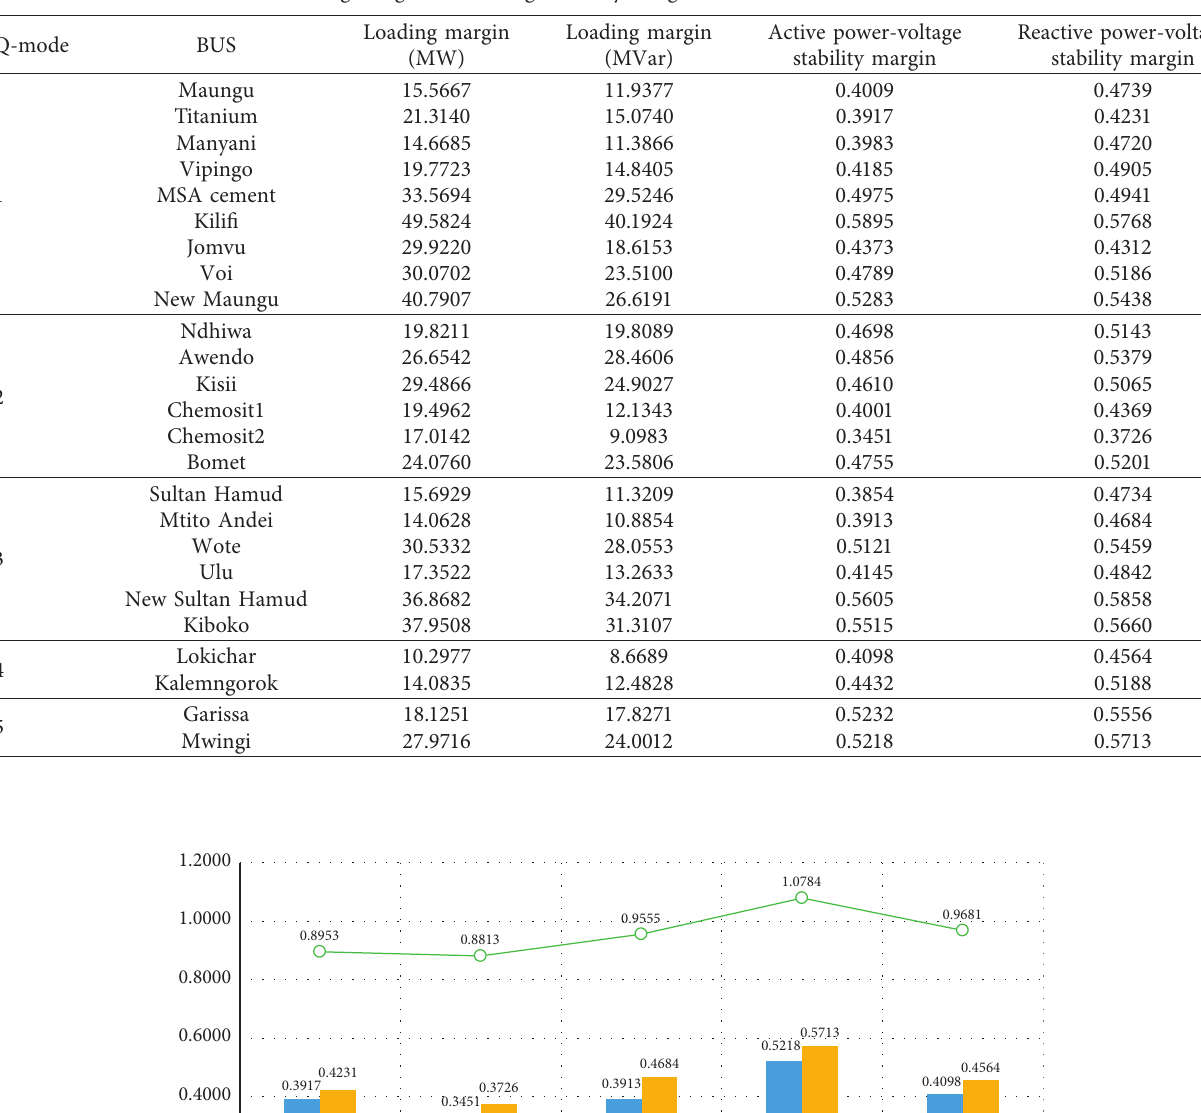
Table 7: Loading margins and voltage stability margins of selected buses in critical modes.